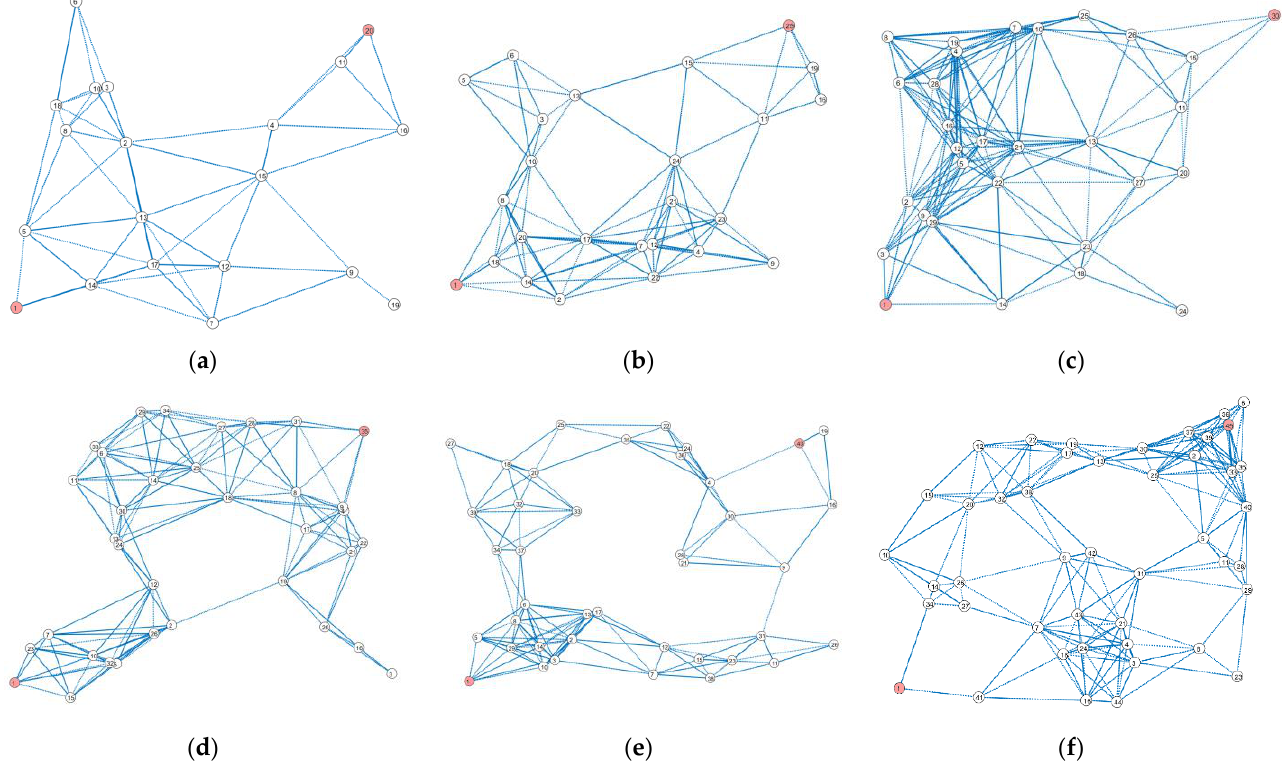
Figure 13. The randomly generated graphs used for evaluating the proposed method: ( a ) Graph20, with 20 nodes and 62 edges; ( b ) Graph25, with 25 nodes and 102 edges; ( c ) Graph30, with 30 nodes and 167 edges; ( d ) Graph35, with 35 nodes and 156 edges; ( e ) Graph40, with 40 nodes and 152 edges; and ( f ) Graph45, with 45 nodes and 206 edges. Table 5. The best paths found by the method proposed for the graphs presented in Figure 13.